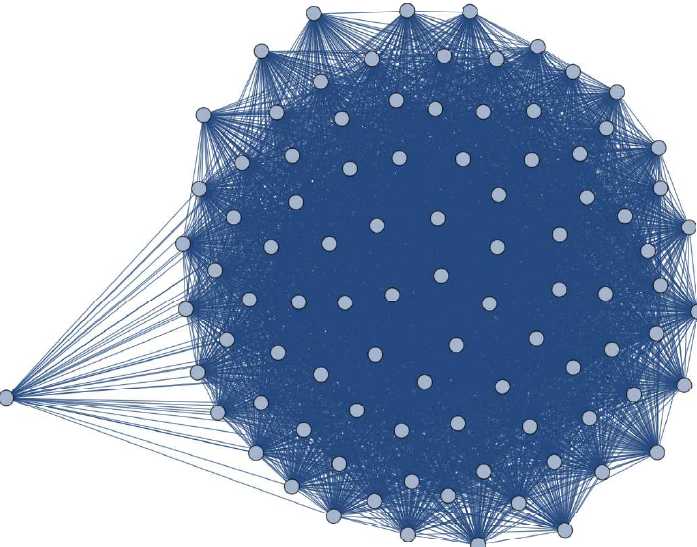
Fig. 1 The network of XU 100 with the threshold value 0.6854.